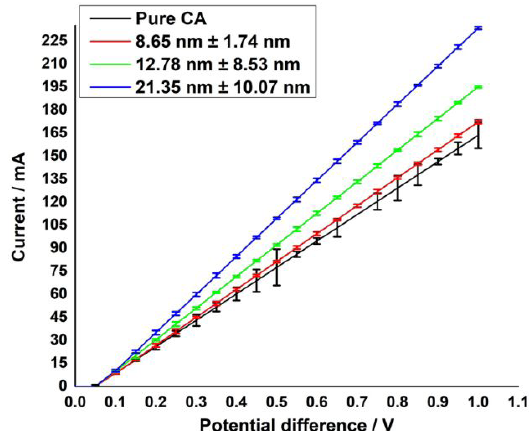
Figure 3. I-V curve of the synthesized electrodes and pure carbon